Question: Briefly state, in one sentence, what is plotted here.
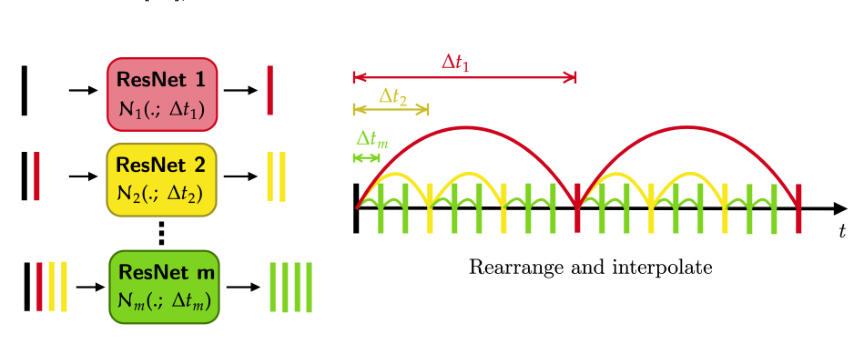
Answer: Coupling various ResNets for multiscale simulations (adapted from Ref. [45])